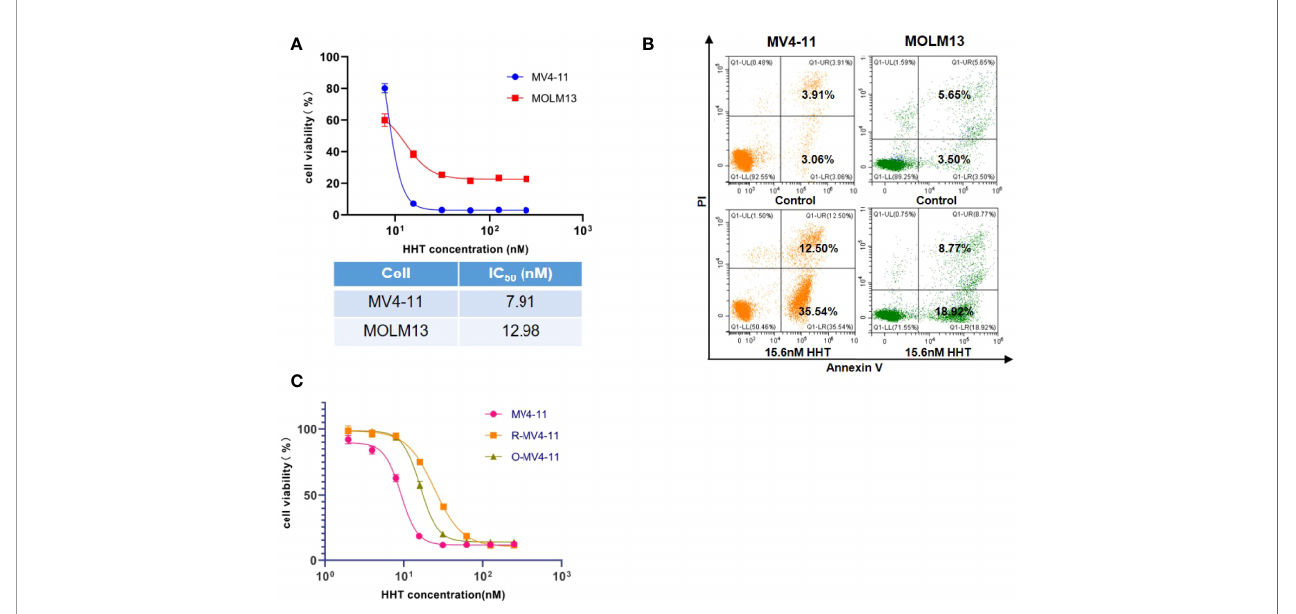
FIGURE 1 | AML cell lines were sensitive to HHT and the establishment of HHT-resistant cells. MV4-11, MOLM13 cells were treated with different concentrations of HHT for 24 hours, and cell viability was detected by CCK-8 (A) . AML cells were treated without or with 15.6 nM HHT for 18 hours, and analyzed by fl ow cytometry (B) . Cells were treated with different concentrations of HHT for 24 hours. The cell viability of MV4-11, MV4-11 resistant strain (R-MV4-11), and off-drug strain (O-MV4-11) was detected by CCK-8 (C) .